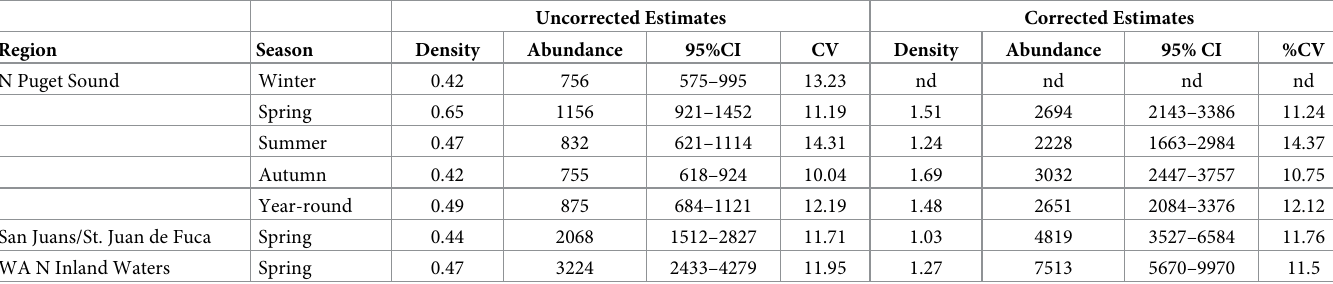
Table 5. Density and abundance estimates for inland Washington harbor seals, Northern Inland Waters.